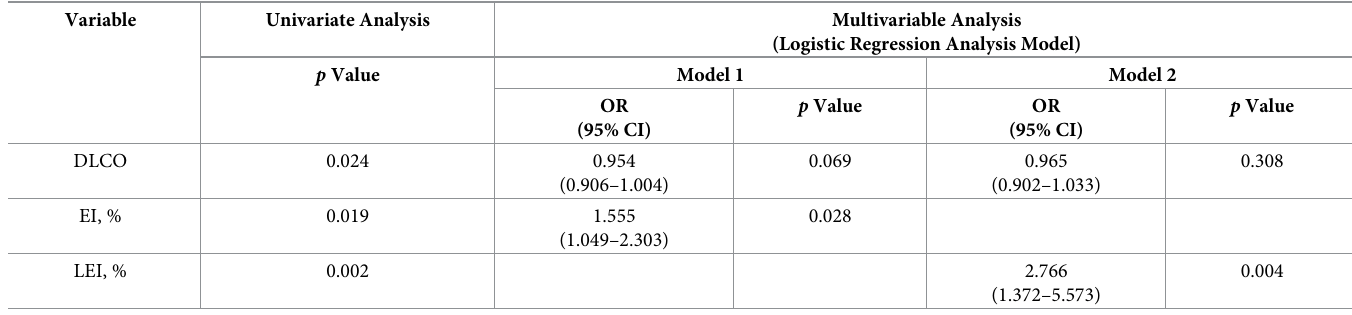
Table 3. Risk factor for prolonged air-leak in anatomical